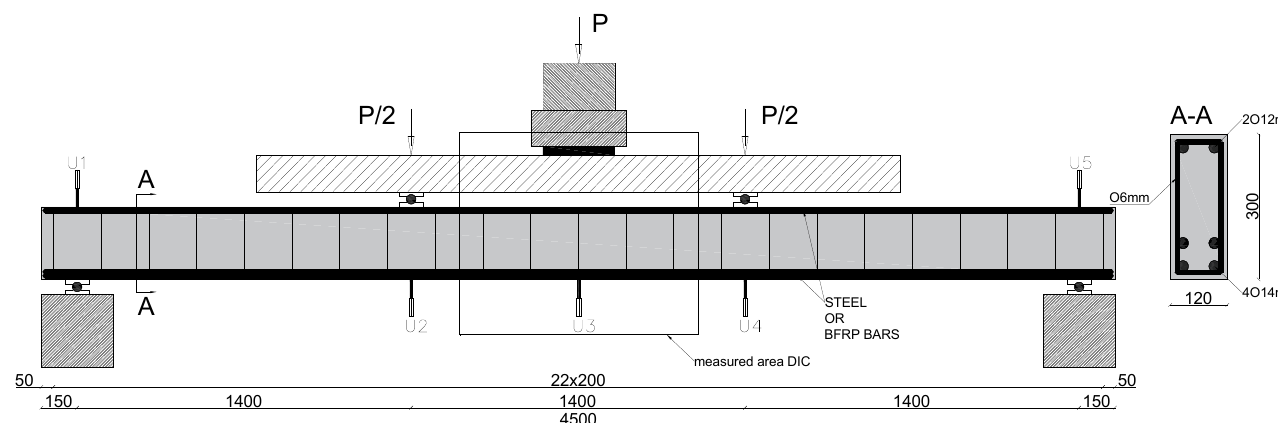
Figure 2. The schemes of tested beams. (P ‐ load, U ‐ deflection measurement place).